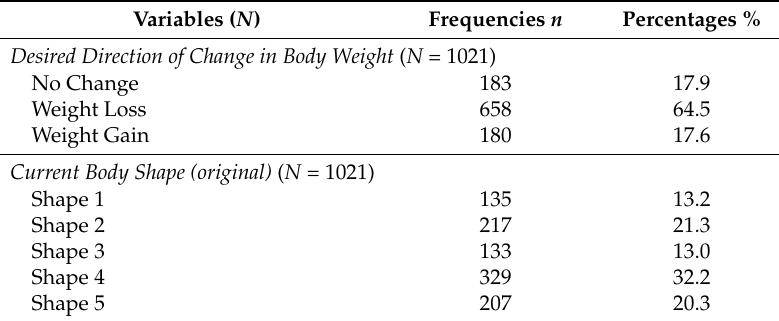
Table 2. Univariates for Experiment